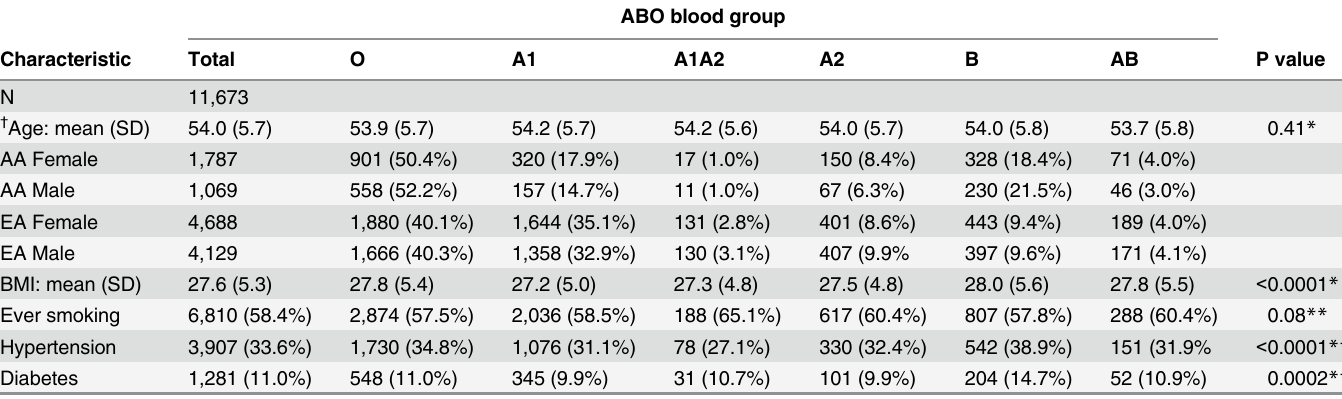
Table 1. Baseline Characteristics of Subjects in Each ABO Blood Group ‡ .